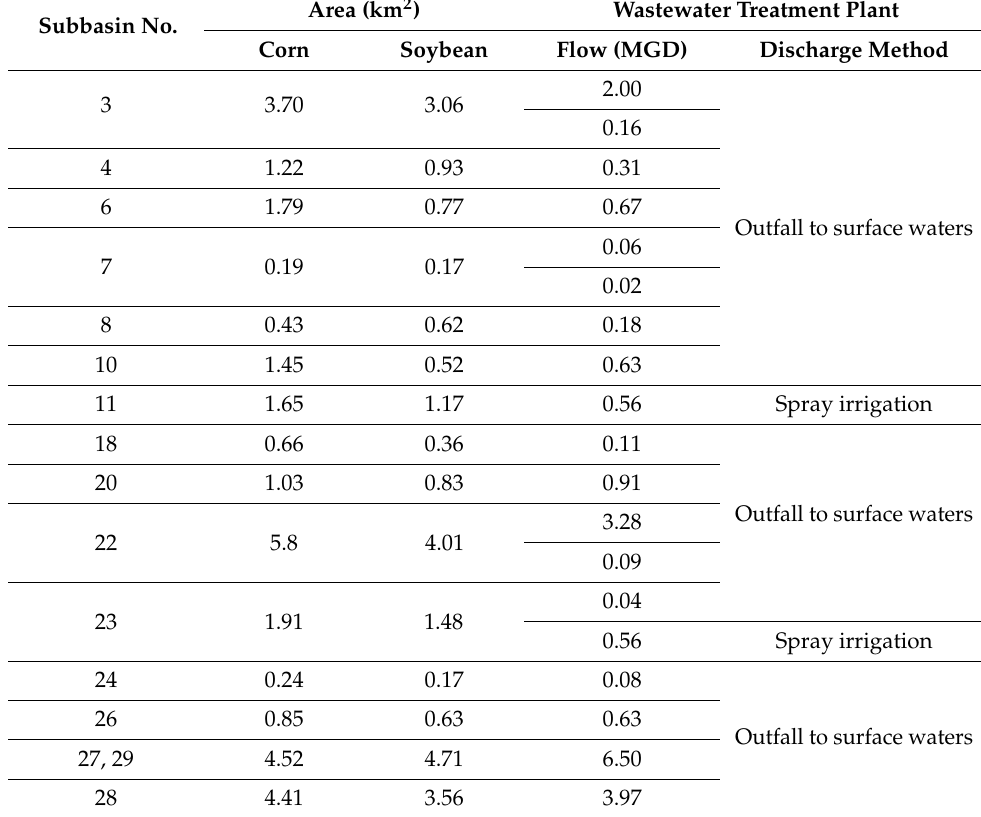
Table 5. Estimated area of corn and soybean (in km 2 ) where reclaimed wastewater can be applied from neighboring WWTPs. A list of existing publicly owned WWTPs is included with their capacity and discharge method information. Area (km 2 ) Wastewater Treatment Plant Subbasin No. Corn Soybean Flow